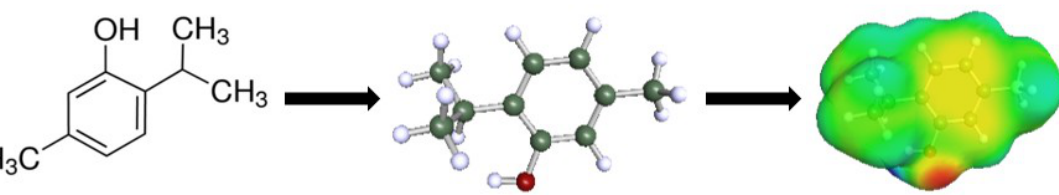
Figure 3. Chemical structure of thymol and translation to sigma surface in COSMO-RS software. The red zone represents the negative charge density of the molecule and the positive values of the sigma, green zones represent non-polar surface of the molecule.